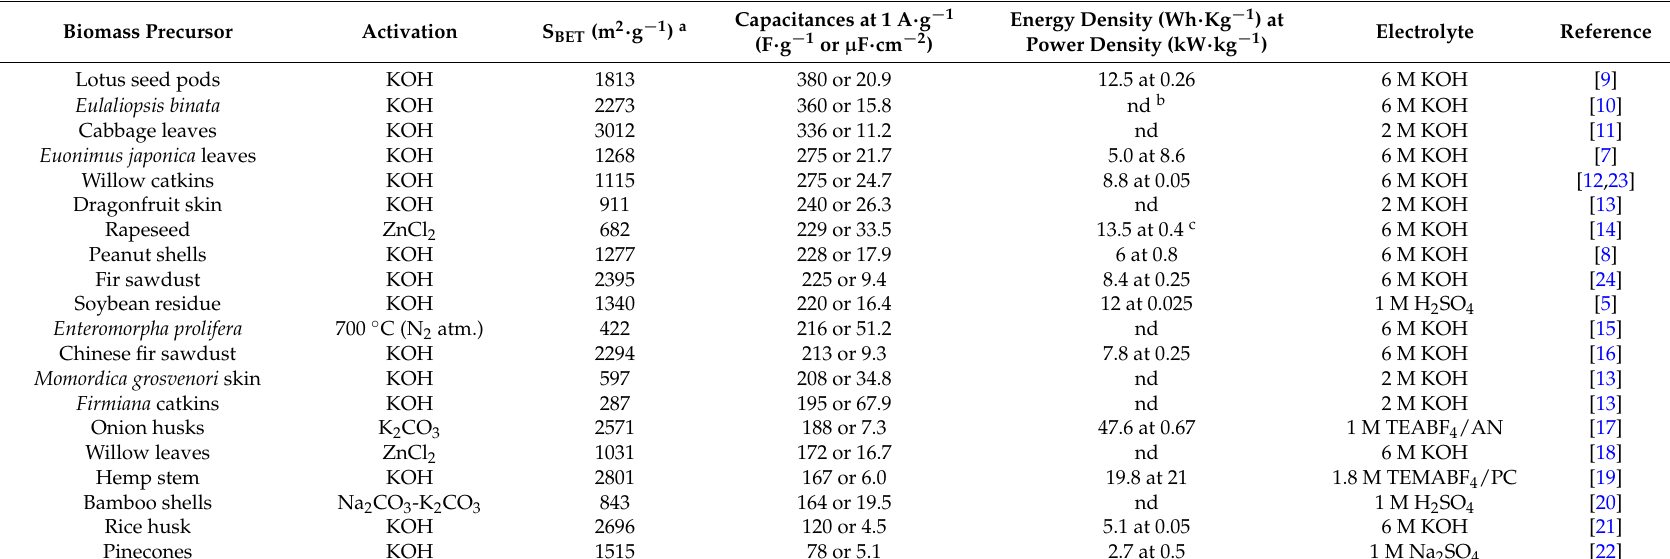
Table 1. Electrochemical capacitance performances of activated carbons from biomass